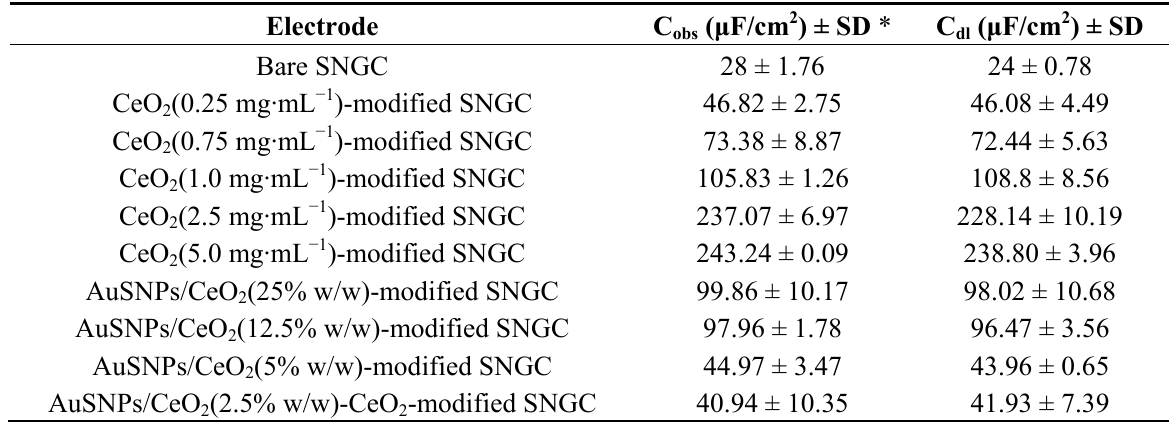
Table 1. Experimental values of the observed capacity ( C ) for the different configurations of the Sonogel-Carbon layer capacity ( C dl